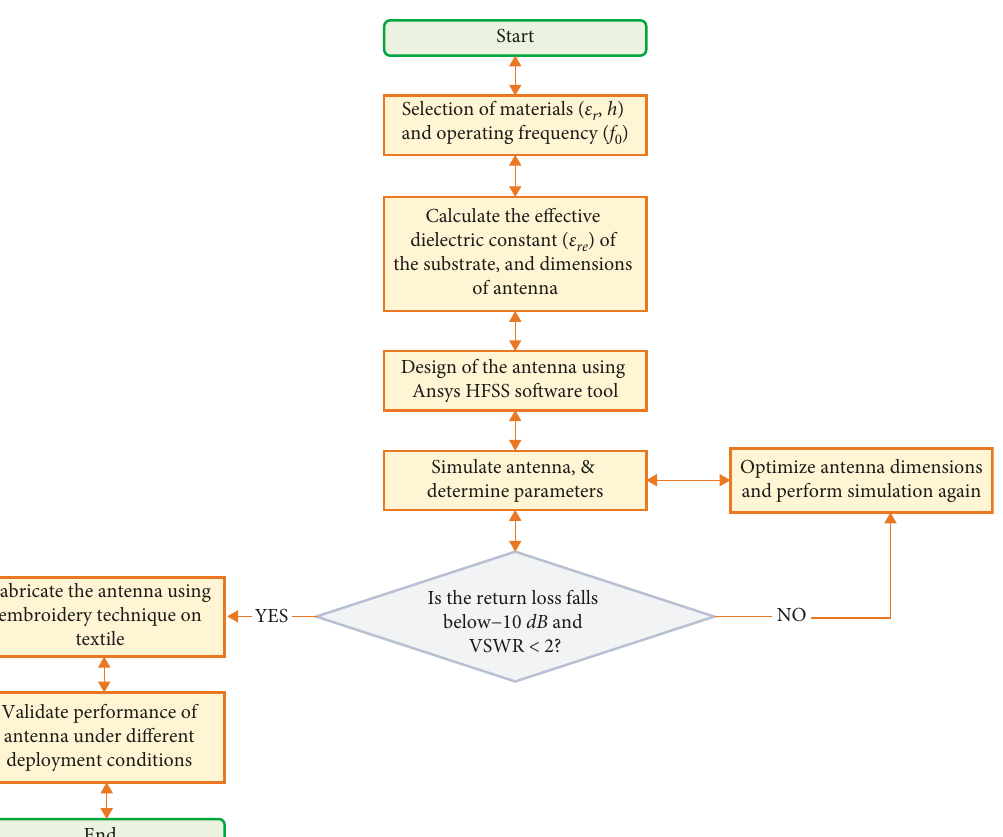
Figure 1: Flowchart for the design of meander-line Z -shaped textile antenna.